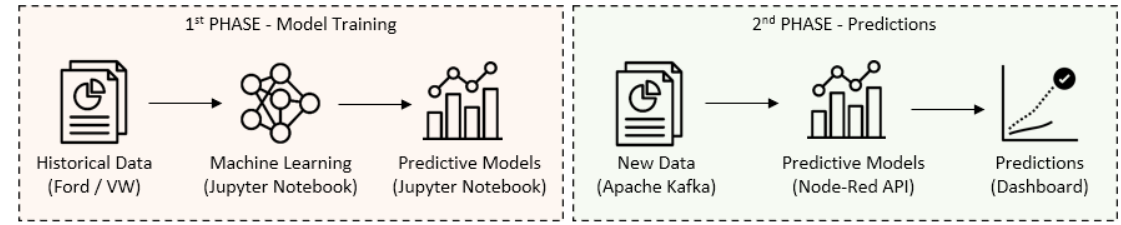
Figure 6. Workflow diagram used to obtain the predictions (predictive models), using data from Introsys robotic cells.